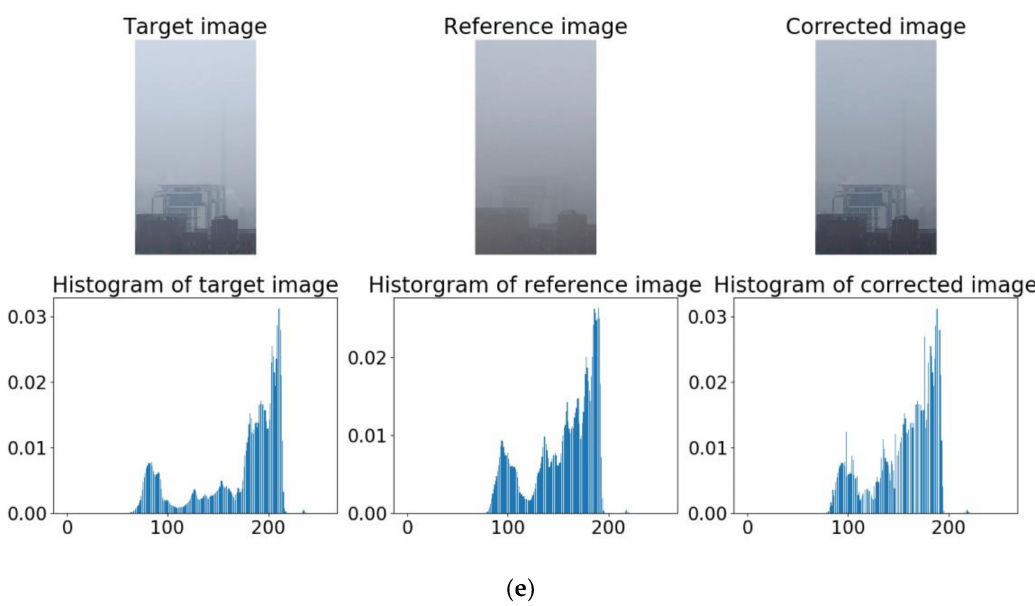
Figure 11. Contrast before and after brightness correction. ( a ) is a histogram comparison before and after brightness correction when the level is excellent; ( b ) is a histogram comparison before and after brightness correction when the level is good; ( c ) is a histogram comparison before and after brightness correction when the level is light; ( d ) is a histogram comparison before and after brightness correction when the level is moderate; ( e ) is a histogram comparison before and after brightness correction when the level is heavy.